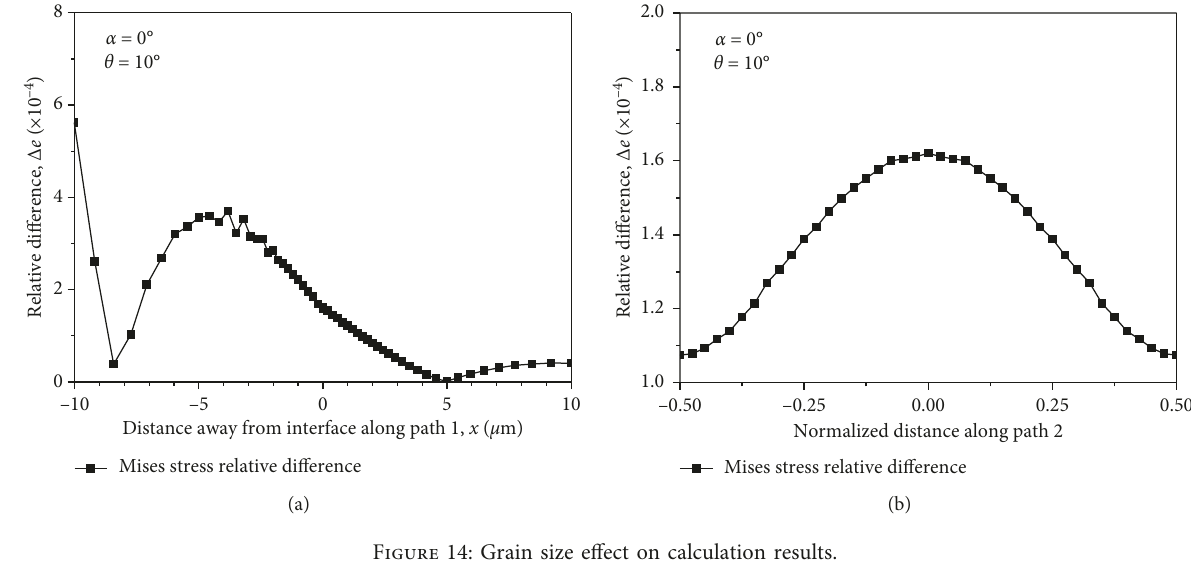
Figure 14: Grain size effect on calculation